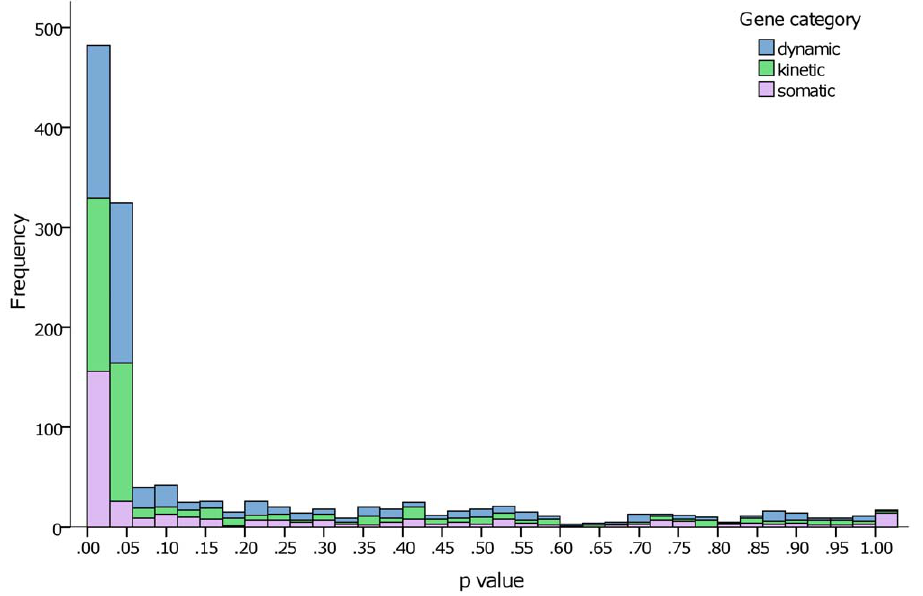
Figure 6. Distribution of p values in 161 full-text primary research articles in pharmacogenetics.